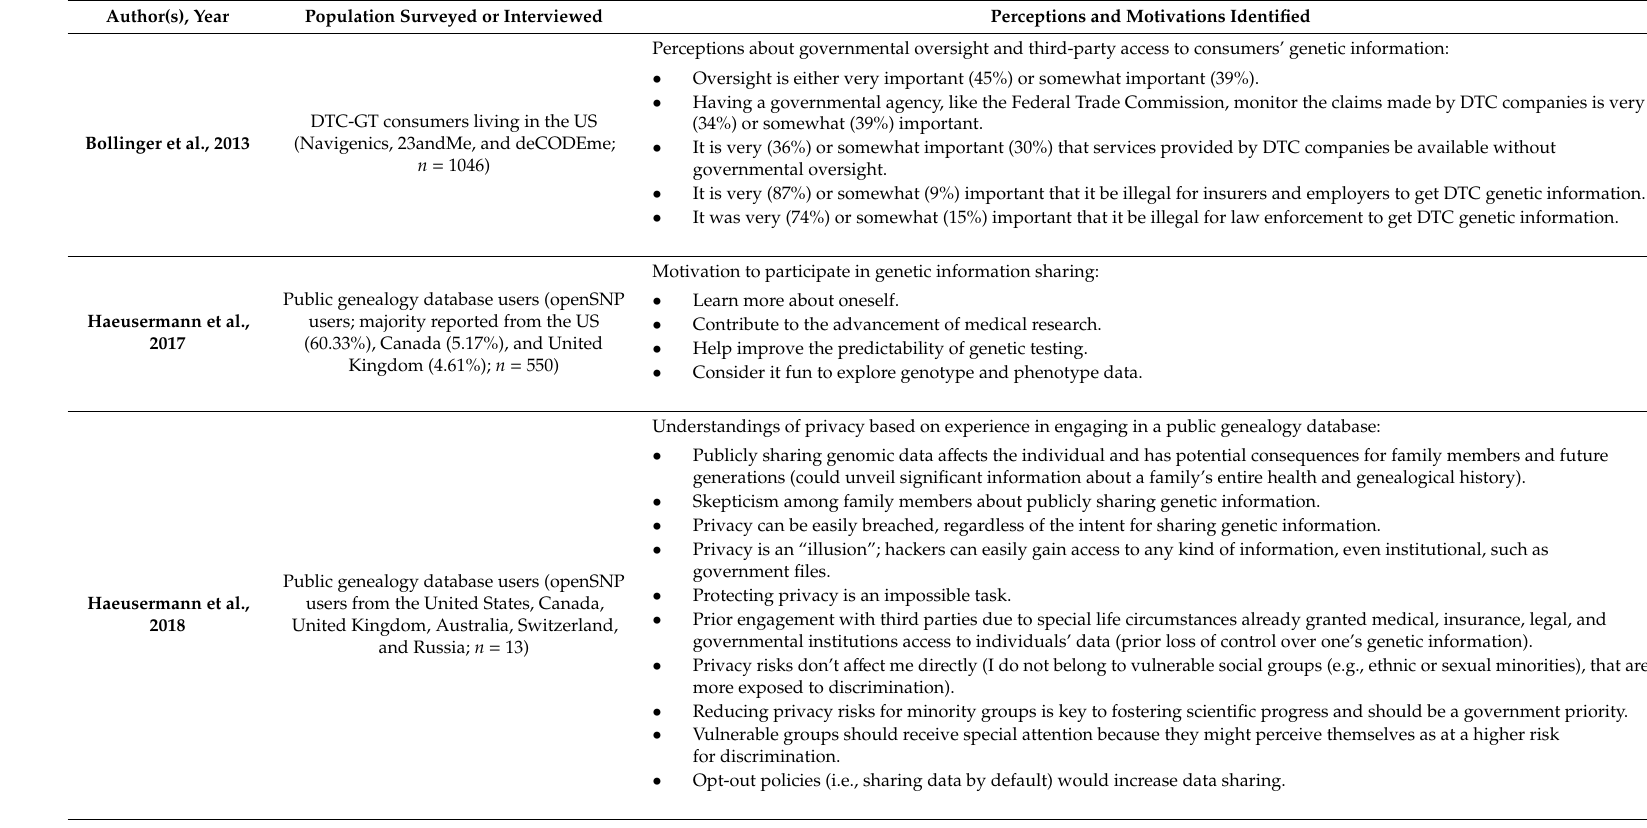
Table 1. Direct-to-consumer genetic testing (DTC-GT) consumer perceptions about genetic information privacy